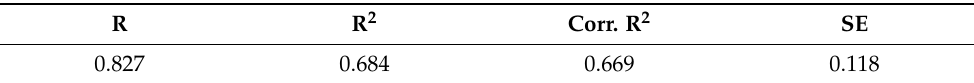
Table 4. Final model of the forward-stepping multiple linear regression analysis ( n = 47) with the predictors’ cardiac interoceptive accuracy at baseline, change in positive affect, and the criterion variable cardiac interoceptive accuracy after yoga. Independent